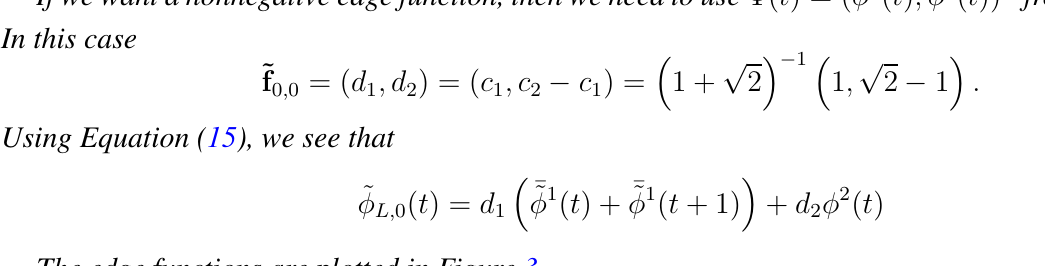
( left ) and the nonnegative edge function using ˜ φ L, 0